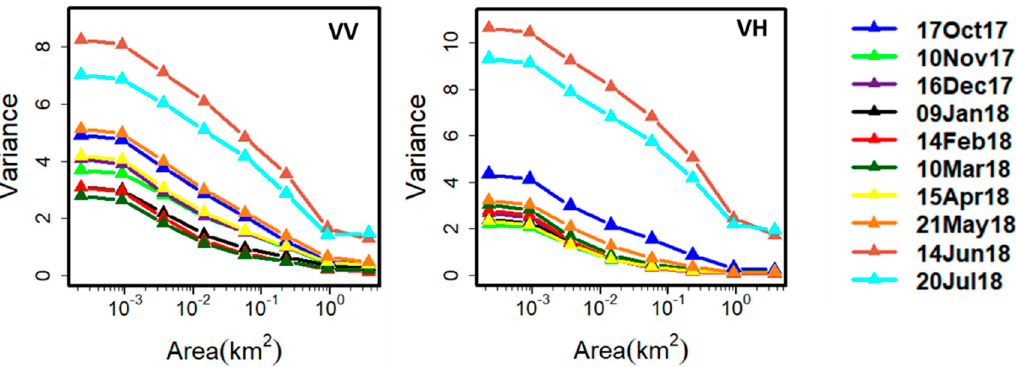
Figure 13. Temporal evolution of the spatial variance of Sentinel-1 VV ( left ) and VH ( right ) BSC coefficients in descending mode for homogenous barren land covered with snow in the winter over North Dakota during 2017–18 as a function of scale.